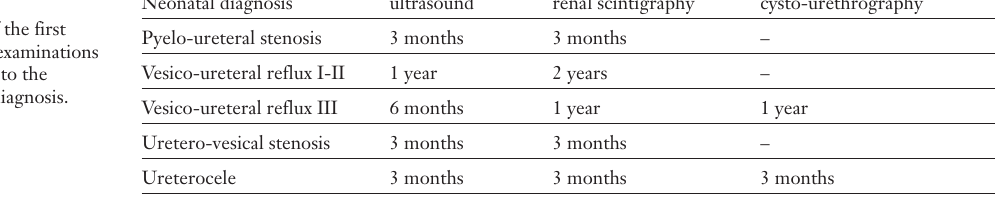
Timing of the first postnatal examinations according to the neonatal